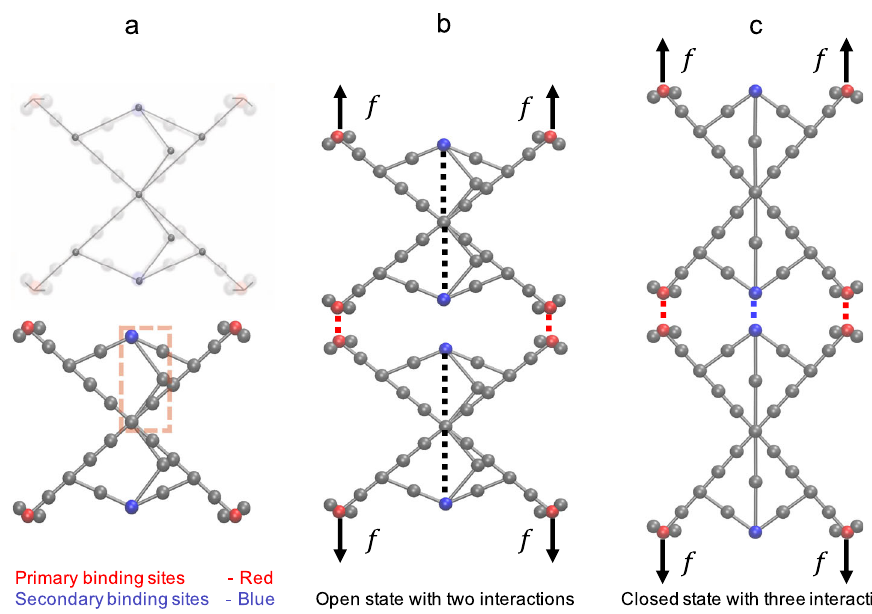
Fig. 1 Schematics of X-shaped nanoparticles. a Each nanoparticle is formed by rigid members connected with hinge joints (gray nodes). Each nanoparticle has primary binding sites (PBS, red), secondary binding sites (SBS, blue), and switch mechanisms. The hinge-like switch is highlighted with a dashed box. Gray beads have steric repulsion to create inaccessible volume determining the shape of the nanoparticles. b When two nanoparticles are in the open state, their switch members are angled and they can form a dimer via two intermolecular interactions (red dashed lines). c When two nanoparticles transition to the closed state, the switch members become straight and the dimer forms an additional intermolecular interaction (blue dashed line). The switch interactions and applied external forces are indicated by black dashed lines and black arrows,